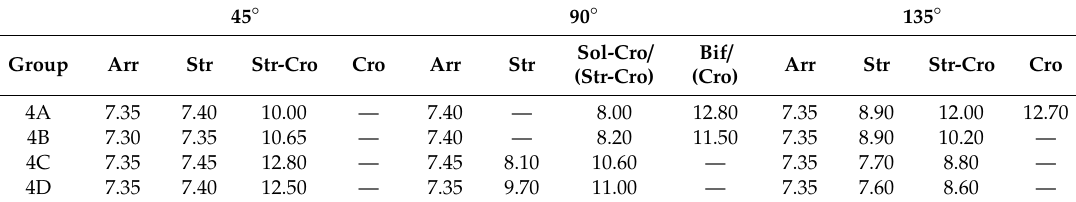
Figure 13. Fluid pressure zones for different interaction modes.